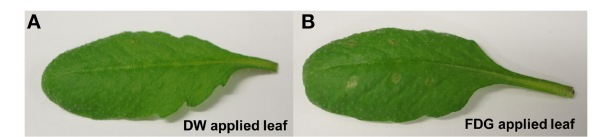
FIGURE 1 | FDG application affected local leaf tissue. Mature leaf was scratched on abaxial surface at 6 spots and 5 µ L of distilled water (DW) (A) , FDG (20 mg.mL − 1 ) (B) was applied locally on each spot. Leaf pictures were taken after 4h. Dehydrated spots were visible at FDG application site.